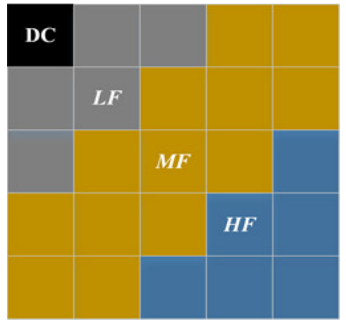
Figure 3. Classification of N u × N v DCT coefficients.